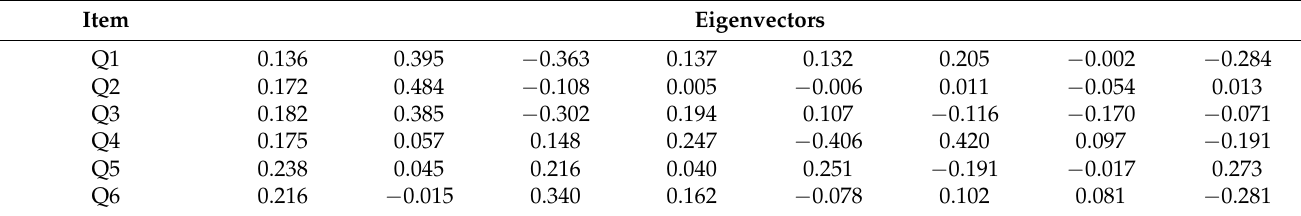
Table 1. Principal component and cumulative contribution